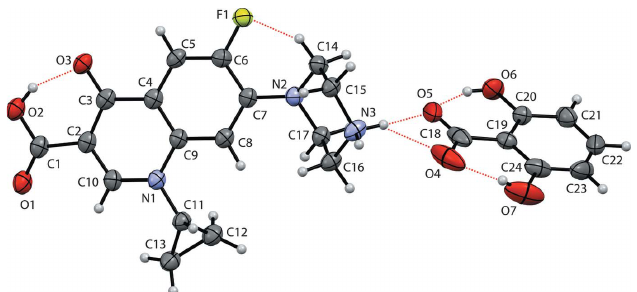
Figure 1 Displacement ellipsoid (50% probability level) drawing with the atomic labelling scheme for compound (I) showing the hydrogen bonds within the selected asymmetric unit.